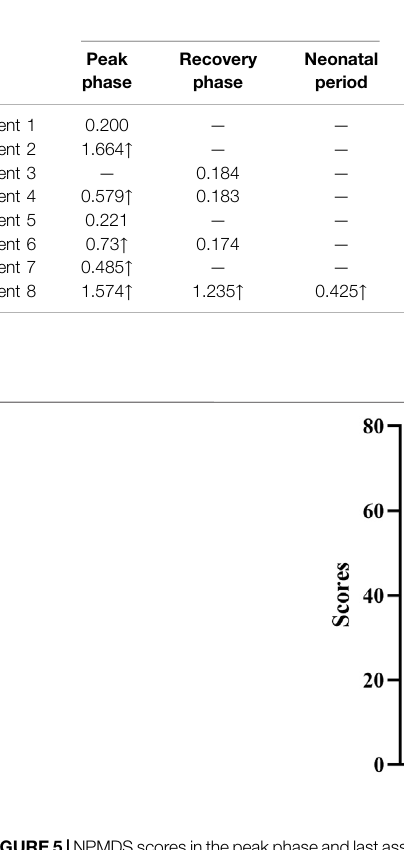
FIGURE5| NPMDSscoresinthepeakphaseandlastassessment.a,Alltherecruitedpatients( n (cid:1) 8);b,Patientswhoreceivedtherapy(Patient1,5,6,7,8; n (cid:1) 5); c, Patients who gave up therapy (Patient 2, 3, 4; n (cid:1) 3).